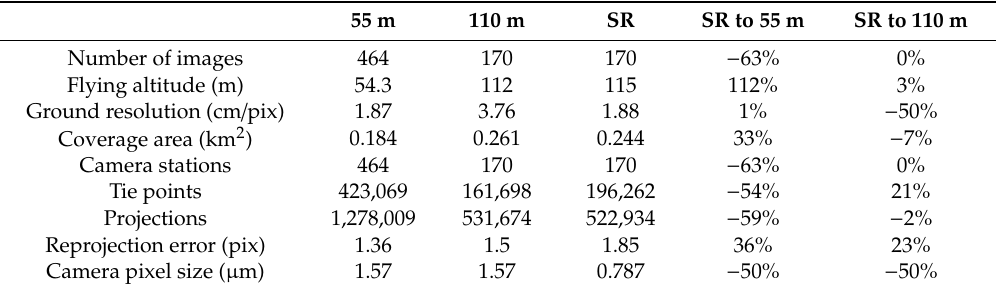
Table 7. Image alignment results for the Mavic Pro.